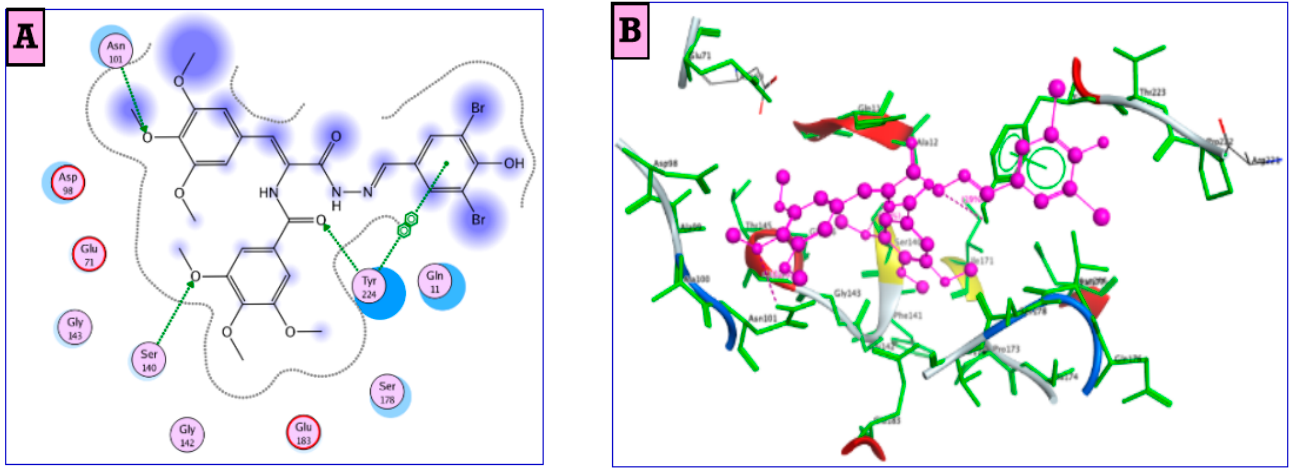
Figure 9. ( A ) show the 2D interactions of Schiff base 4h into tubulin active site (PDB code: 1SA0).